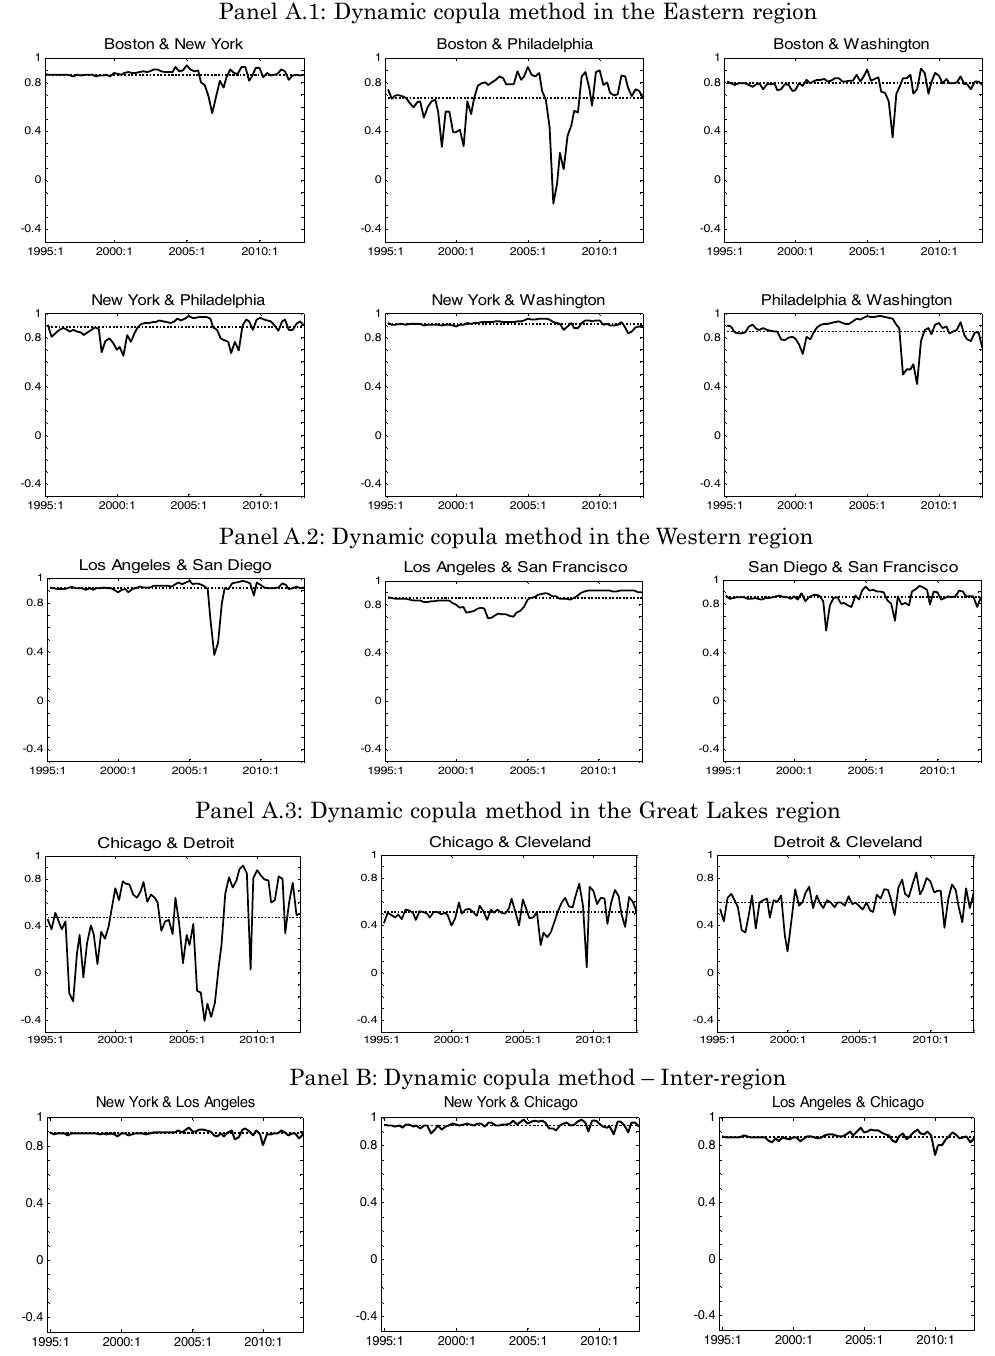
Panel a: Dynamic copula method – Intra-region Panel a.1: Dynamic copula method in the eastern region